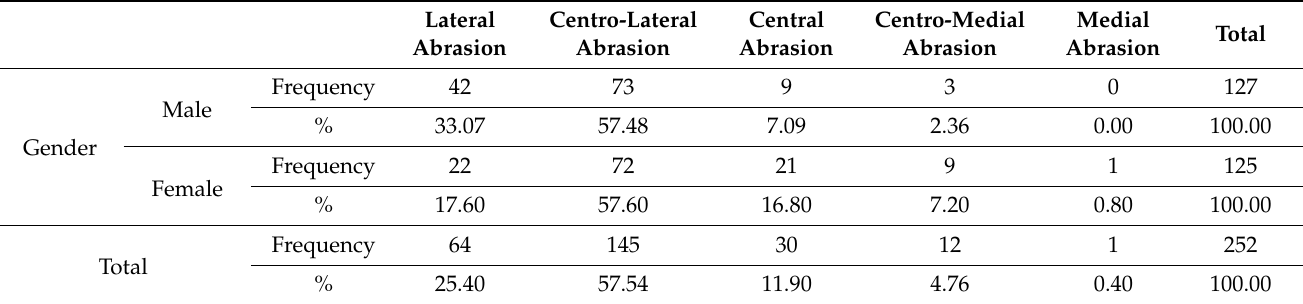
Table 10. Relationship between gender and left shoe abrasion classification (X 2 = 15.04, df = 4, p =